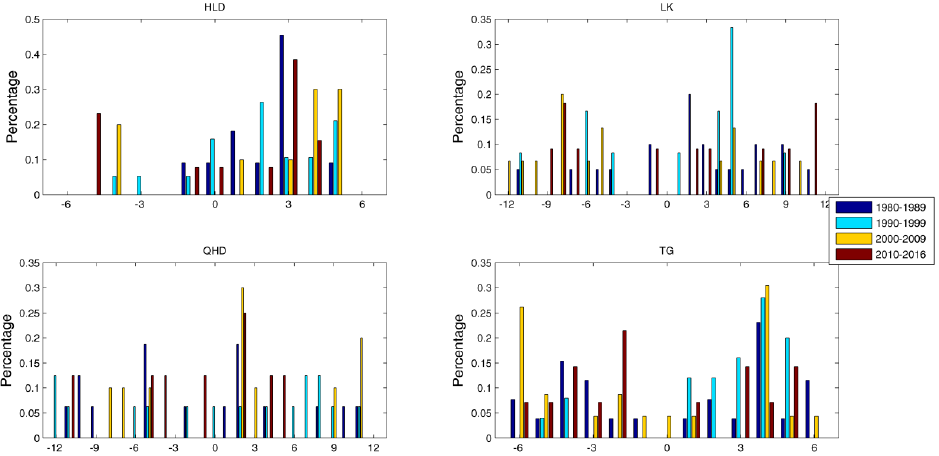
Figure 9. Distributions of surge peaks for all 10-year periods at four tide gauges; y axes are the percentage, and x axes are the hours before and after the high tide.